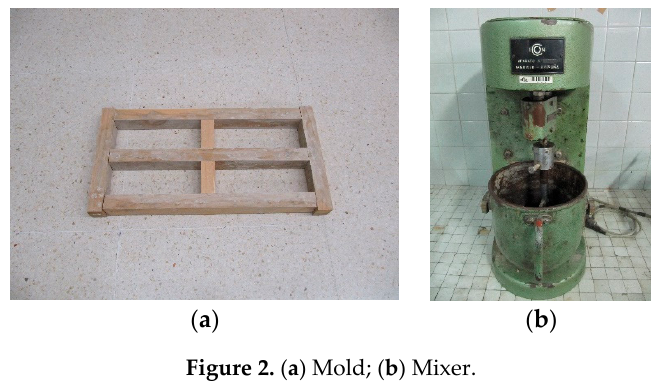
Figure 2. ( a ) Mold; ( b ) Mixer.